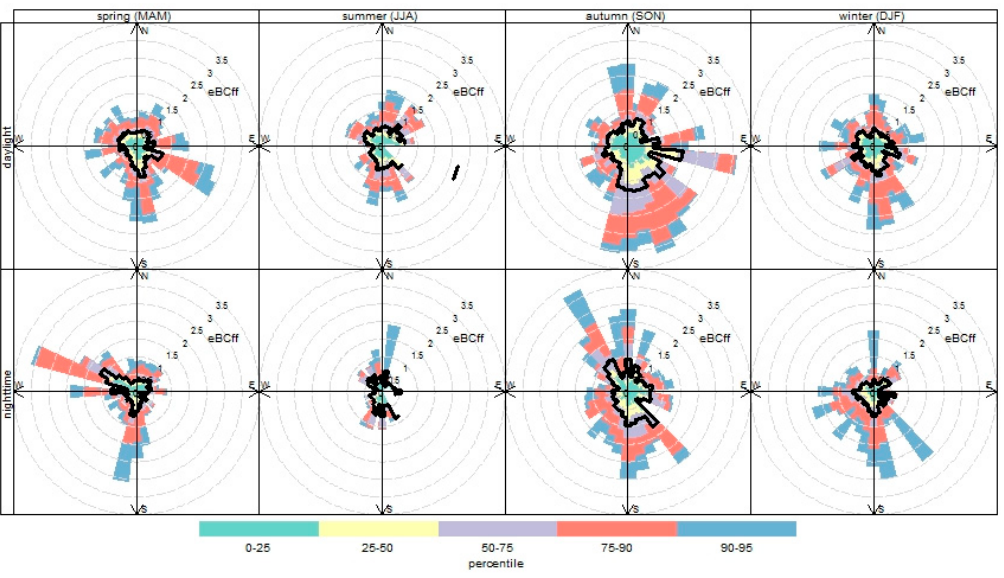
Figure 10. Percentile rose plot of eBCff concentrations (µg m − 3 ).